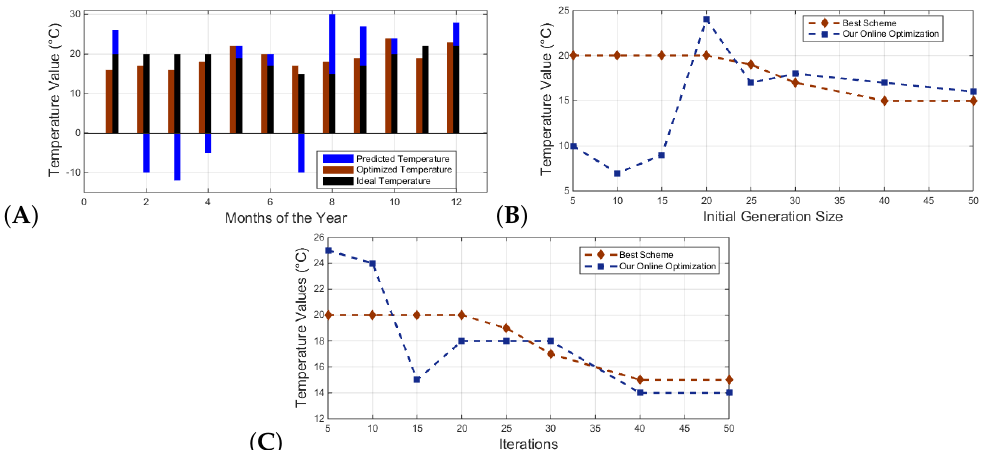
Figure 6. Performance evaluation of our GA. ( A ) Comparison between ideal, predicted, and opti- mized temperature value. ( B ) Optimized temperature value when varying initial population size.